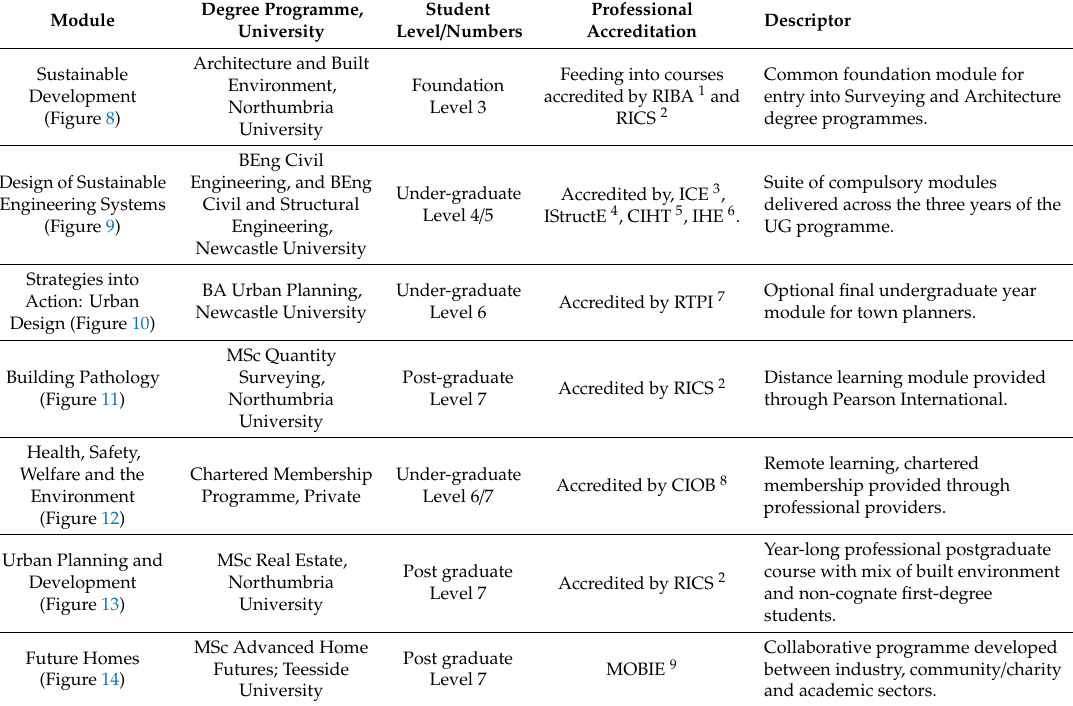
Table 1. Scope of modules “mapped” against the helix model of collaboration.